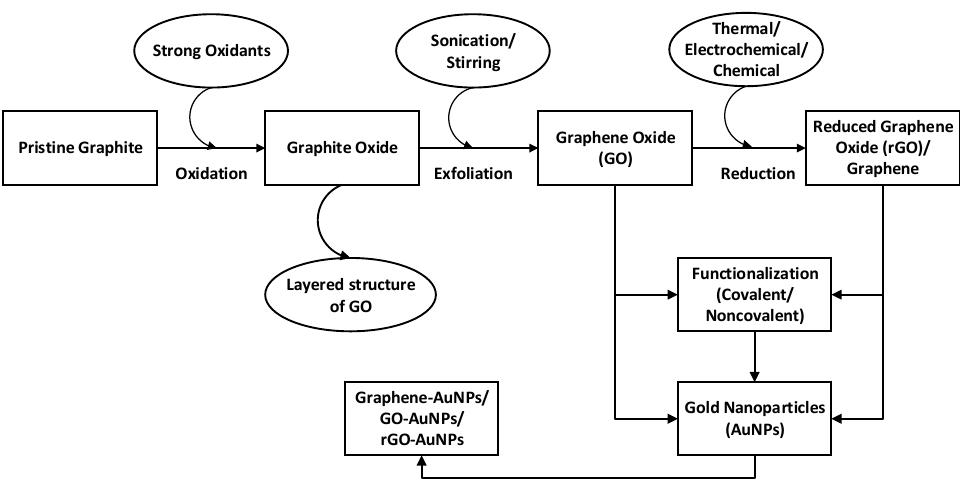
Figure 2. Schematic representation of the formation of graphene–AuNPs nanocomposites.